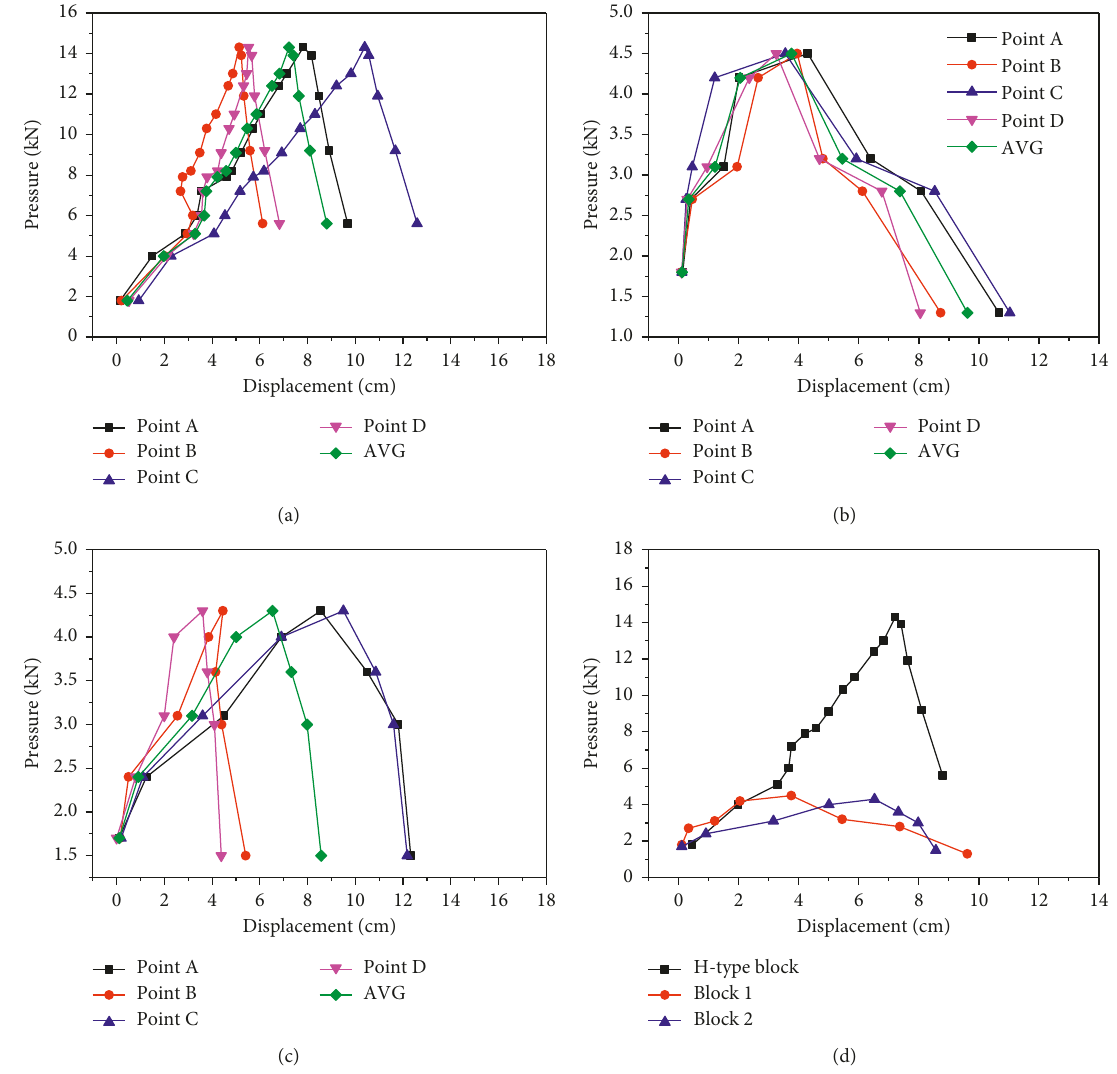
Figure 13: Pressure-displacement curve of 4 corner points of three types of blocks. (a) Pressure-displacement curve of the H-type gravity mutual-aid steel slag core concrete block. (b) Pressure-displacement curve of the traditional block 1. (c) Pressure-displacement curve of the traditional block 2. (d) Three kinds of block pressure-average displacement